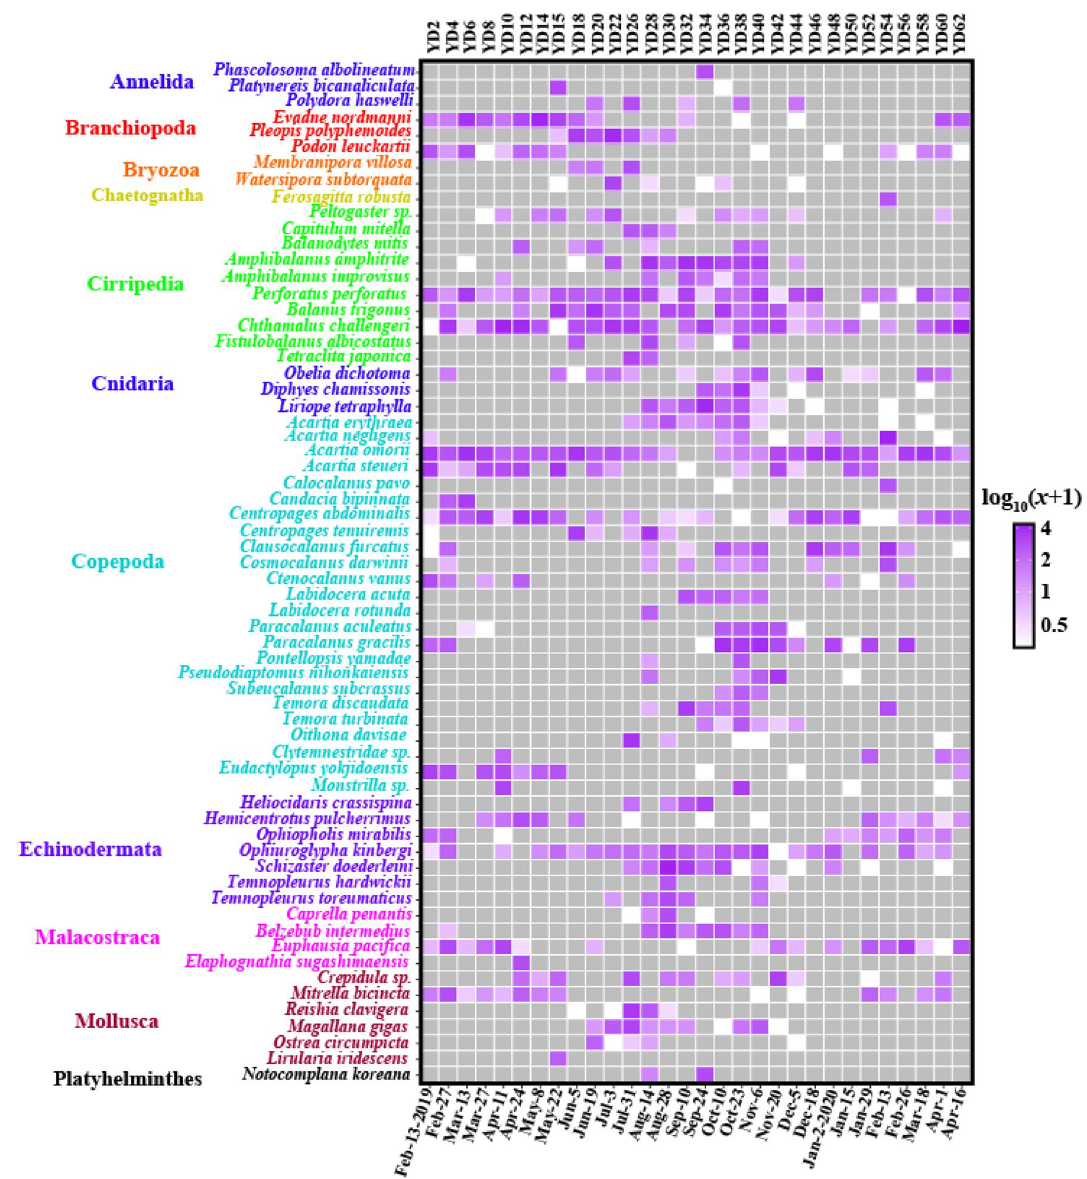
Figure 4. Heatmap of 64 “common” zooplankton taxa. Each read count is transformed log 10 (abundance + 1). The colors indicate relative abundance from high (purple) to low (white), and gray is 0. Figures were produced using R (v4.0.3, https:// www.R- proje ct. summer-autumn (G3) species. Finally, Clausocalanus furcatus (Copepoda) appeared in greater abundance in winter than in other seasons (Fig. 5; Table 2). All top 5 taxa which contributed significantly to distinguishing each seasonal group were included in the “common” taxa. The result of the full SIMPER analysis is attached (Supplementary Analysis S1). Searching for candidates of potential invasive species. In order to evaluate the reliability of the overall metabarcoding classification, the results of our analysis were compared with the national list of marine species (NLMS) 26 . Of the 267 species identified in our data (including sequence-read depth < 10), ~ 75.7% (202/267) was confirmed to be the correct taxonomic name (species level: 192; genus level: 9; family level: 1) by NLMS and ~ 24.3% (65/267) of the remaining species were not found (Table S8). One of them was a freshwater taxon ( Cyclops vicinus ) 27,28 and 39 species in our data were only the same genus name in NLMS (Table S8). Moreover, 26 taxa did not have genus names as well as species names. C. vicinus is suggestive of debris that probably inflowed from the Nakdong River 29 . We confirmed whether the COI sequences for the 38 species that only existed in the NLMS with the same genus name had their congeneric species registered in NCBI. Twenty taxa of the 38 species have COI sequences for their congeneric species in the NCBI database. The remaining 18 taxa do not have COI sequences registered for any congeneric species in NCBI. Therefore, in the 18 cases, there